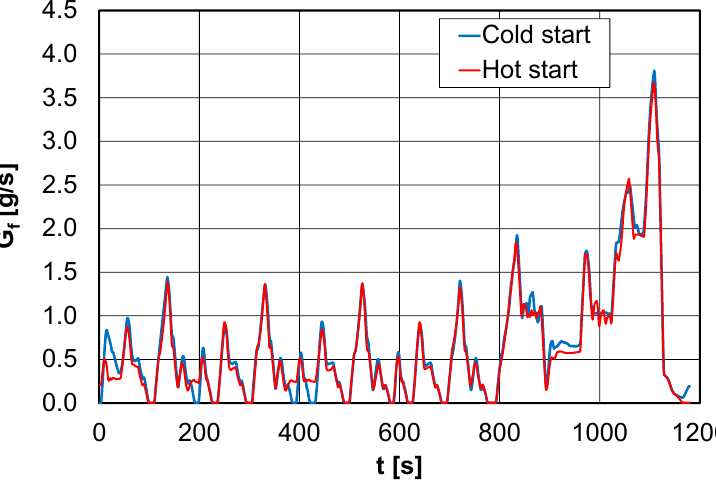
Figure 8. Mass of fuel consumed (G f ) for cold and hot engine start.